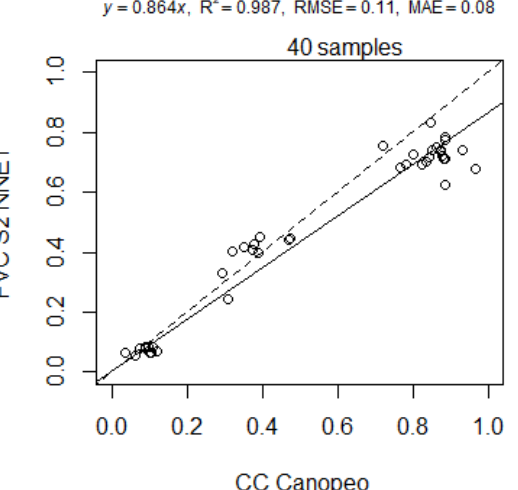
Figure 6. Scatterplot comparing CC from Canopeo with the FVC derived from Sentinel-2 data.